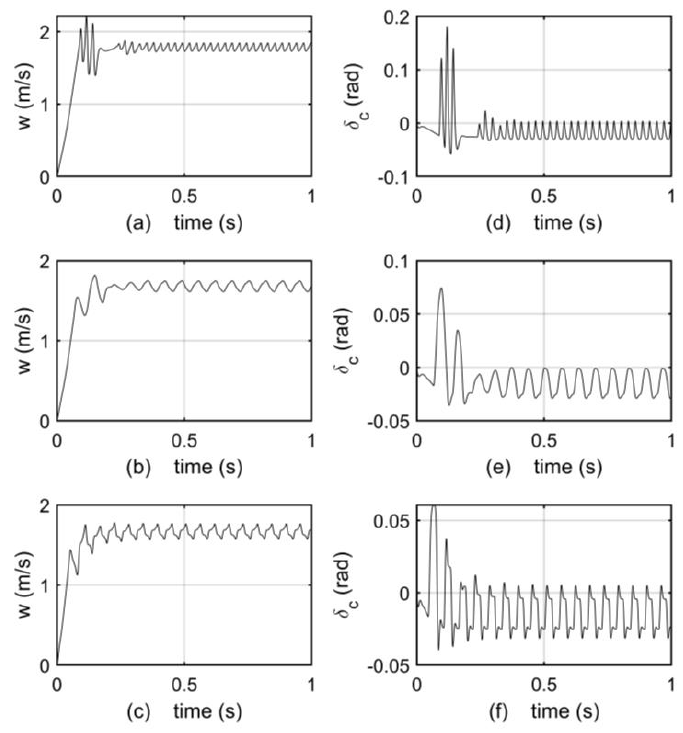
Figure 3. Closed-loop system response for delay dependent system with trivial initial condition and δ c = − 0.3 q − 30 θ + 15 z , δ f = 0. ( a , d ) delay-free model and corresponding control signal; ( b , e ) delayed model and corresponding control signal; ( c , f ) FOM and corresponding control signal. Note that the open-loop system with or without delay is unstable [2]. The free FOM is also unstable, where its unstableness is proven through Matignon’s theorem [25] that the eigenvalues of the FOM do not satisfy the condition represented as in Equation (30) and graphically illustrated in Figure